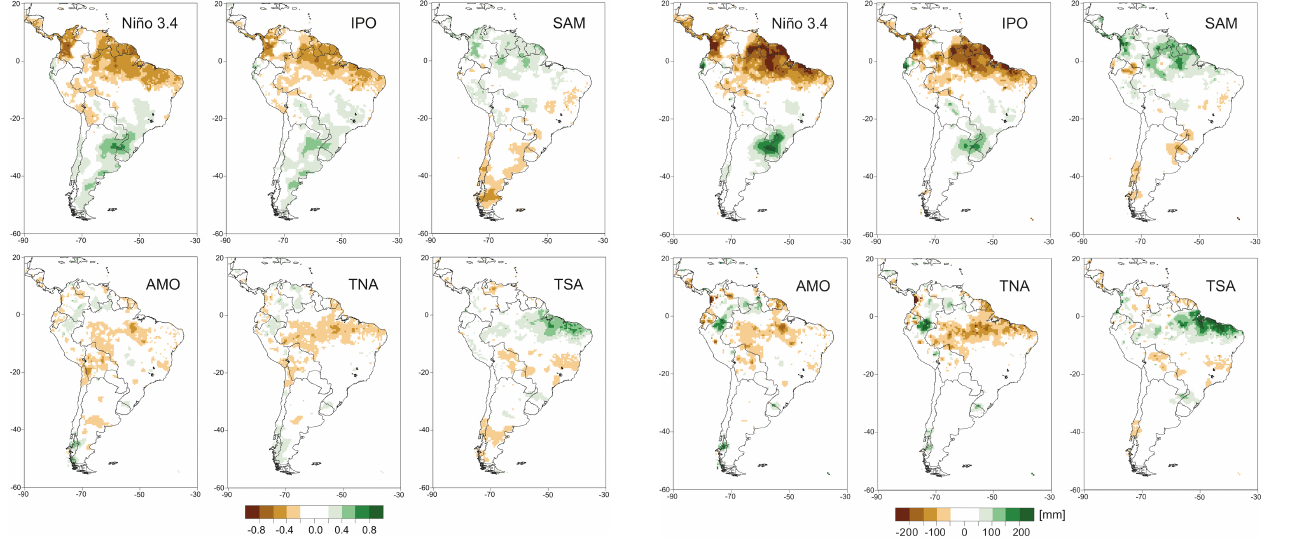
Figure 5. Precipitation regression with modes Niño3.4, IPO (Inter- decadal Pacific Oscillation), SAM (Southern Annular Mode), AMO (Atlantic Multidecadal Oscillation), TNA (tropical North Atlantic SST), and TSA (tropical South Atlantic SST). High positive values of the regression coefficient indicate that positive (negative) precip- itation anomalies occur during the positive (negative) phase of the mode in question. High negative values indicate that the positive (negative) phase of a mode leads to a decrease (increase) in precip- itation at the grid